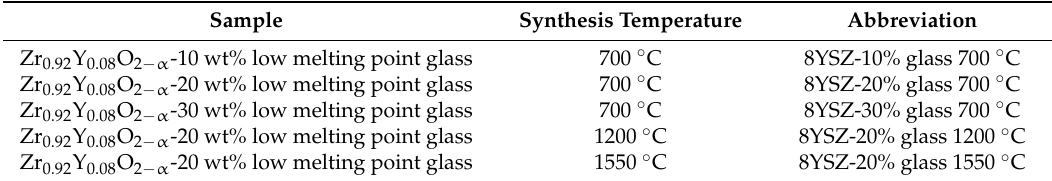
Table 1. The samples synthesized with different synthesis temperature and weight ratio.